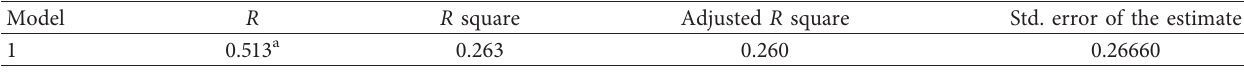
Table 4: Model Summary regarding impact of BIM om planning (model summary).